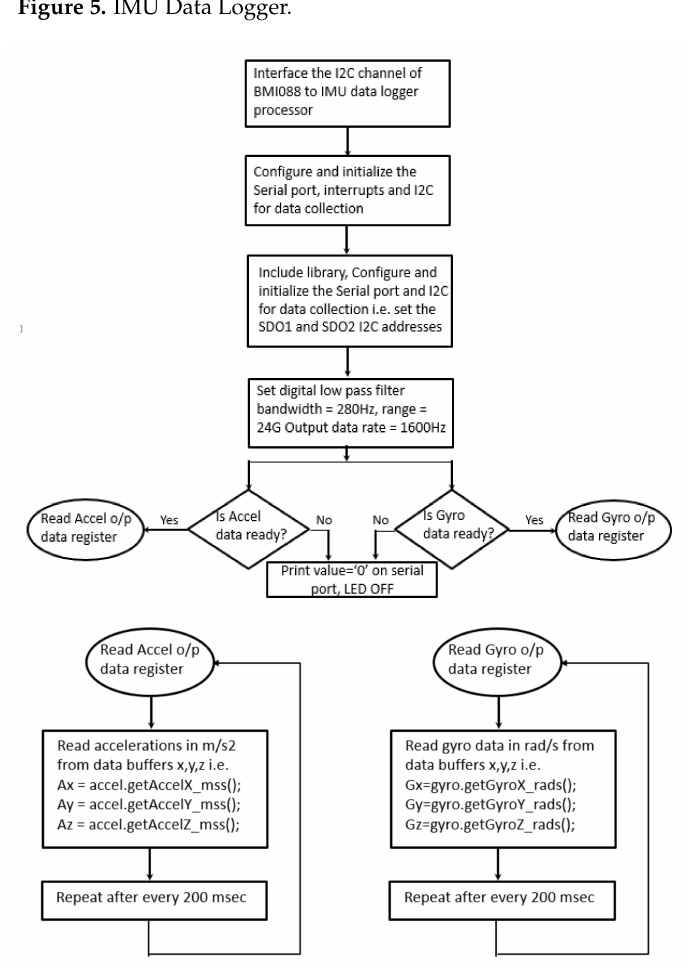
Figure 6. Flowchart for data record handling in IMU Data